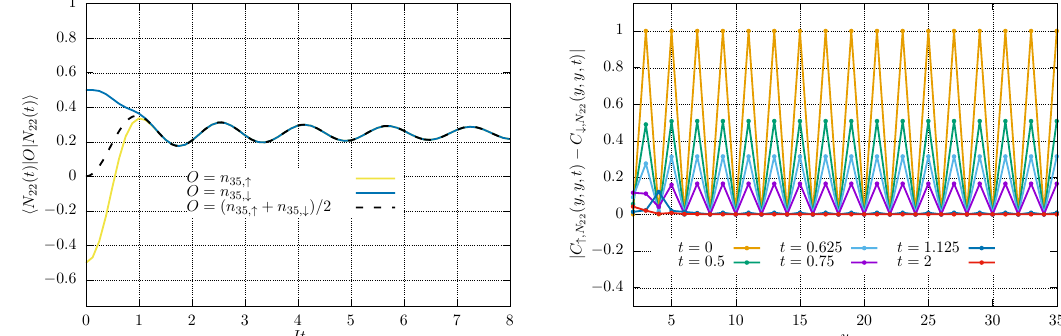
Figure 3: Dynamics of the number operators after a quench from the generalised nested Néel state (119) in the thermodynamic limit. The left panel shows the time ( y , y , t ) , C ( y , y , t ) , and evolution of the densities at x = 35, comparing C ↑ ↓ , N , N 22 22 ( C ( y , y , t ) + C ( y , y , t )) / 2 = 〈 N | d ( t ) | N 〉 / 2. The right panel shows fixed- ↑ , N ↓ , N f y f 22 22 ( y , y , t ) − C ( y , y , t ) | time slices of | C ↑ ↓ , N , N 22 22